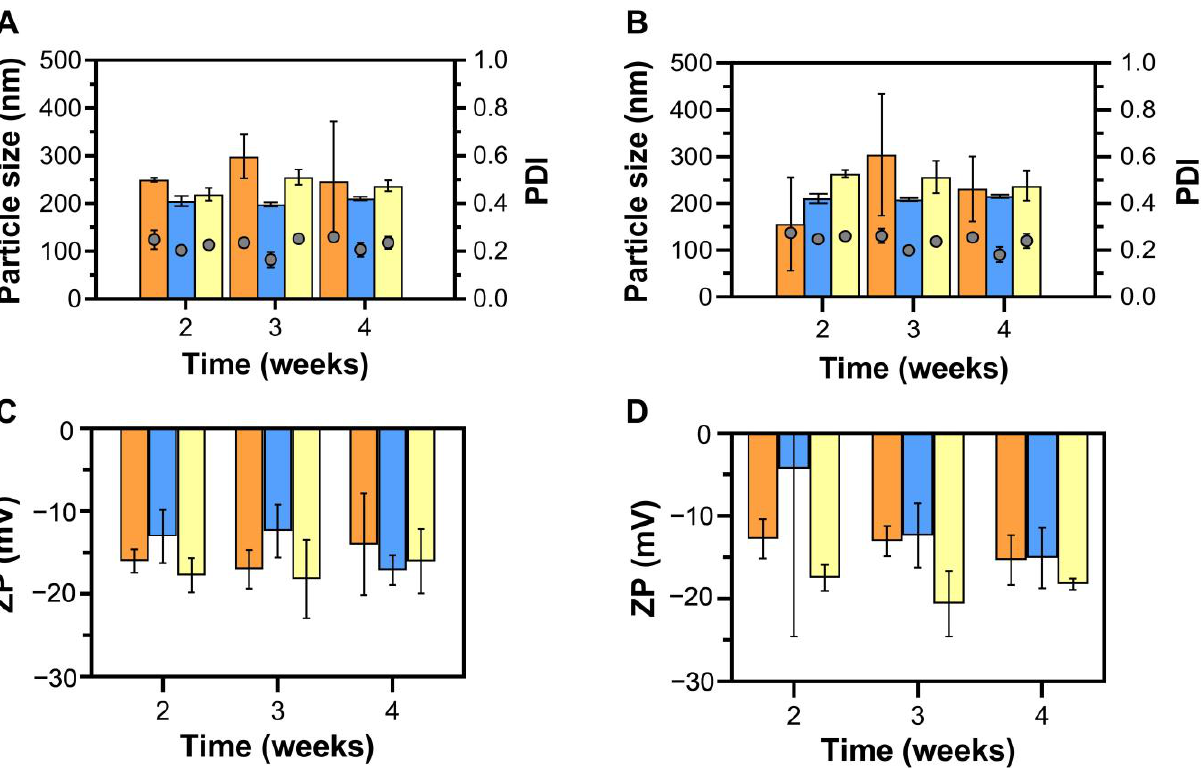
Figure 3. Stability of empty LNLCs prepared by hydrotrope method (M1, orange data), lipid film hydration method (M2, blue data) and emulsification method (M3, yellow data) during 4 weeks in different storage conditions: ( A ) size and PDI at 25 °C, ( B ) size and PDI at 4 °C, ( C ) surface charge (ZP) at 25 °C, and ( D ) surface charge (ZP) at 4 °C. The data are expressed as mean ± standard deviation of least three independent experiments.